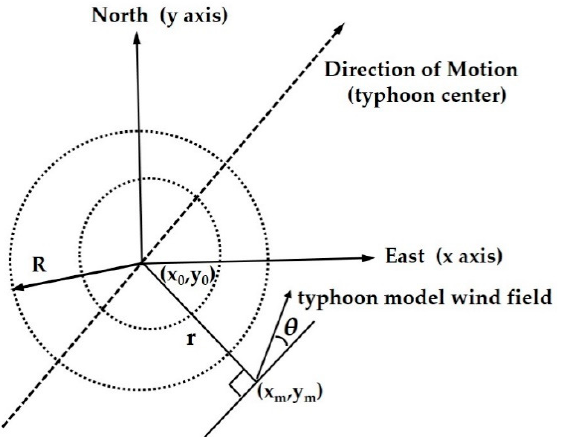
Figure 3. The horizontal schematic diagram of the wind field coordinate system. R: the radius of maximum wind; r: the radial distance from the typhoon center; θ : the inflow angle. The input parameter R can be calculated by Graham and Nunn [47]: R = 28.52 tanh [ 0.0873 ( ϕ − 28 )] + 12.22